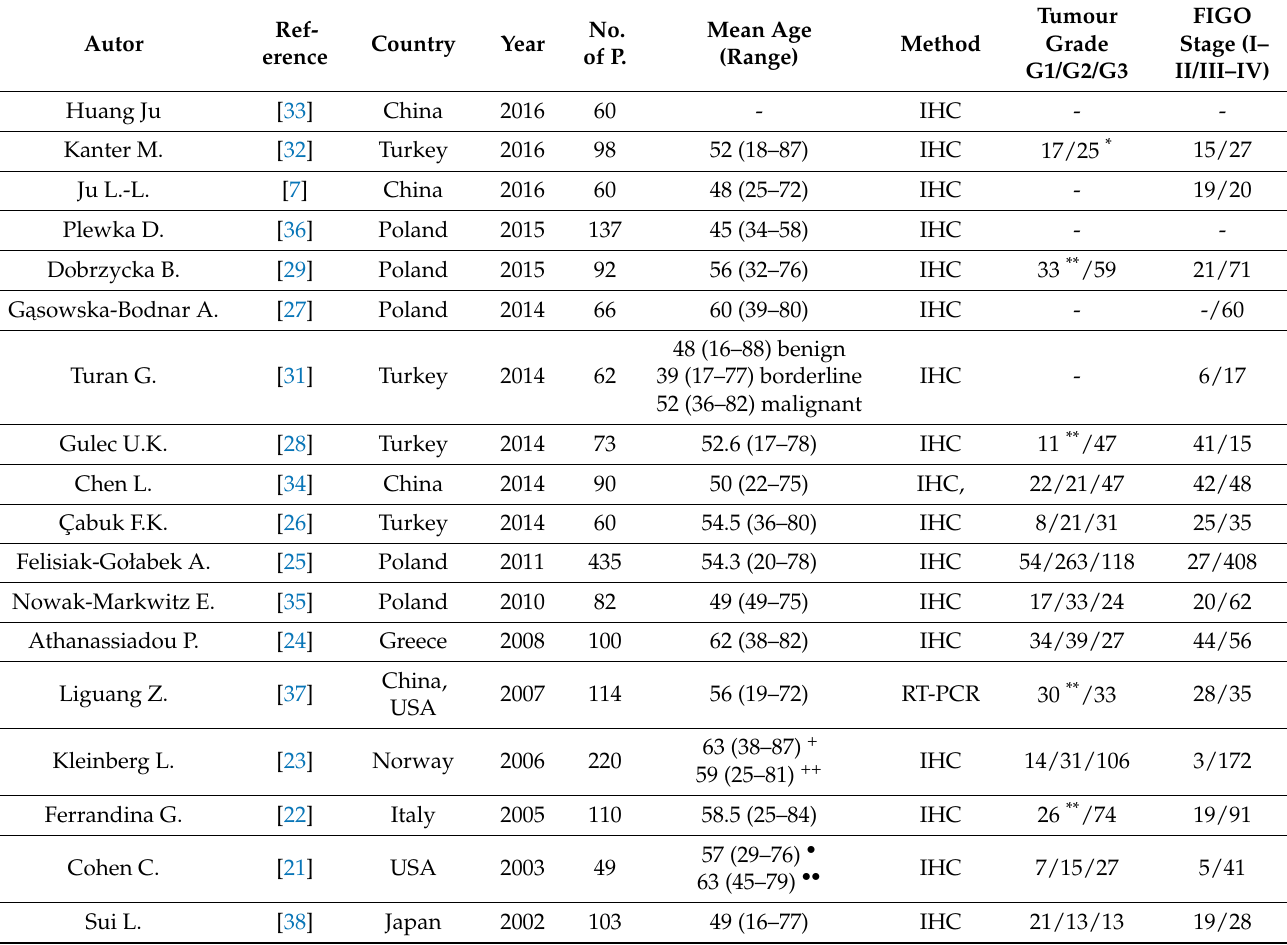
Table 1. Main characteristics of the included